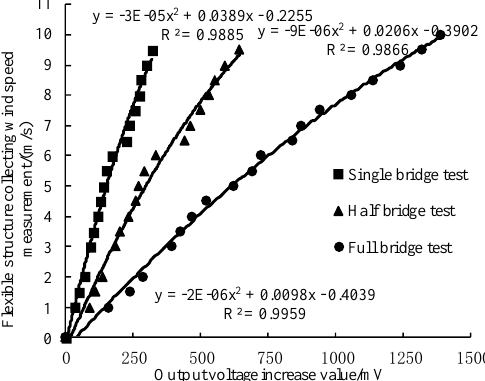
Figure 8. Regression equations for single bridge, half bridge and full bridge circuits.